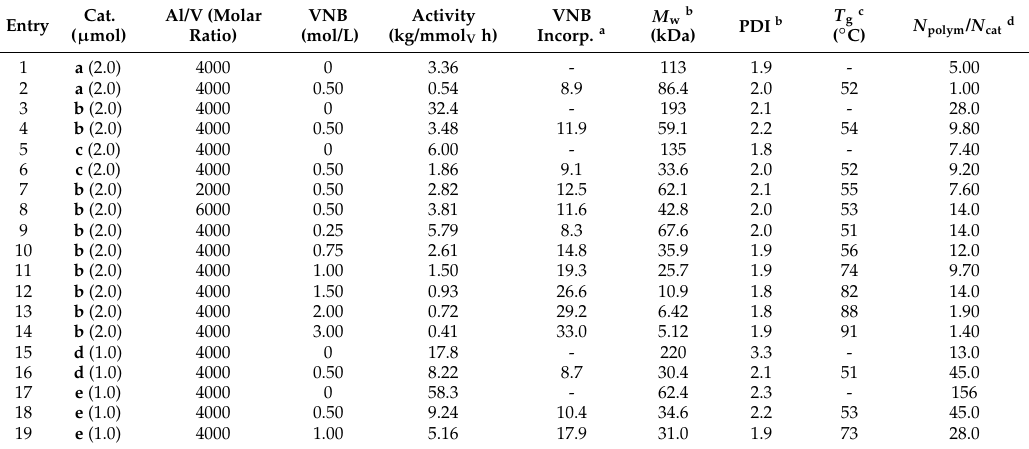
Table 1. Ethylene/VNB copolymerization by oxovanadium(V) complexes.